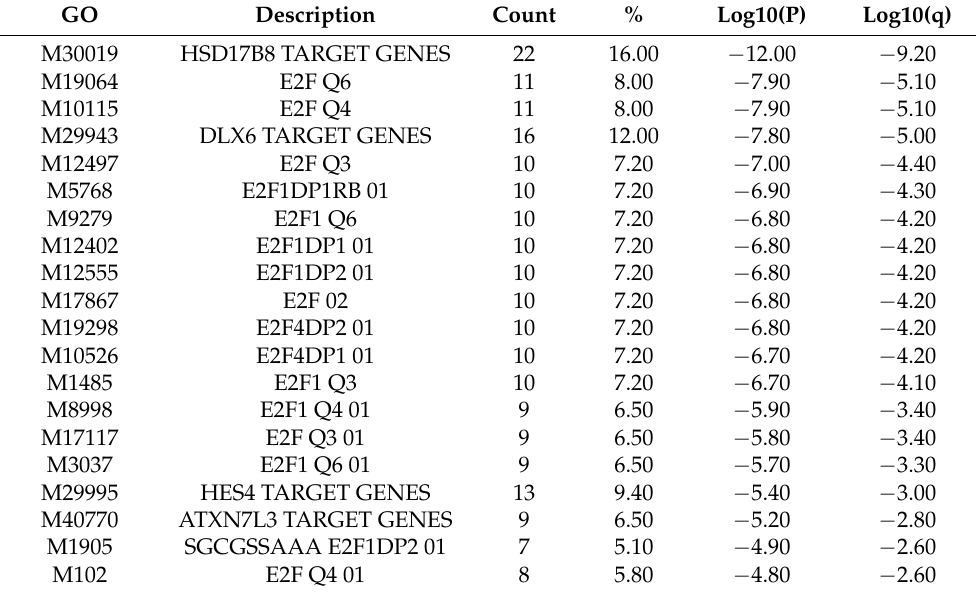
Table 3. Summary of enrichment analysis in transcription factor targets.